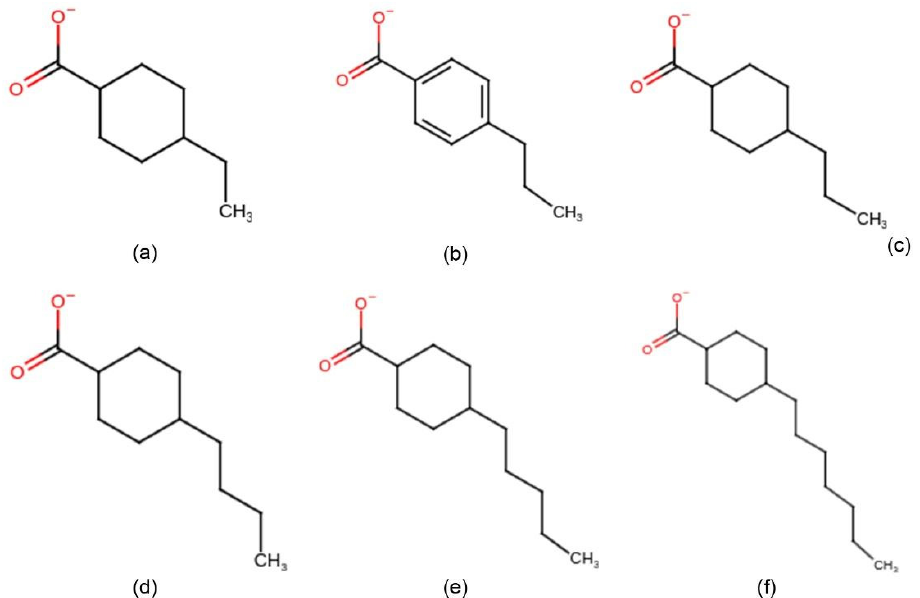
Figure 1. Molecular structure of the studied naphthenic acids: ( a ) c9, ( b ) c10 aromatic, ( c ) c10, ( d ) c11, ( e ) c12 and ( f ) c14.